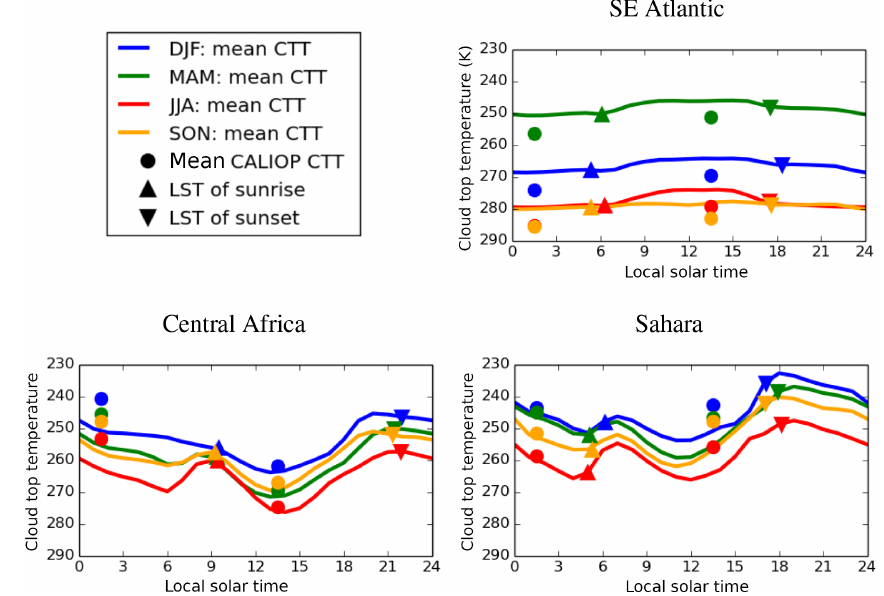
Figure 11. Seasonal mean diurnal cycles of SEVIRI CTT calculated over the period 2005–2015 (solid lines) and mean 2007 SEVIRI minus CALIOP retrieval bias (vertical distance between coloured circles and corresponding coloured lines). Biases are shown at the mean LST for the day- and night-time CALIOP overpasses. Also shown are the local solar times of sunrise (triangles) and sunset (nablas) for each region and